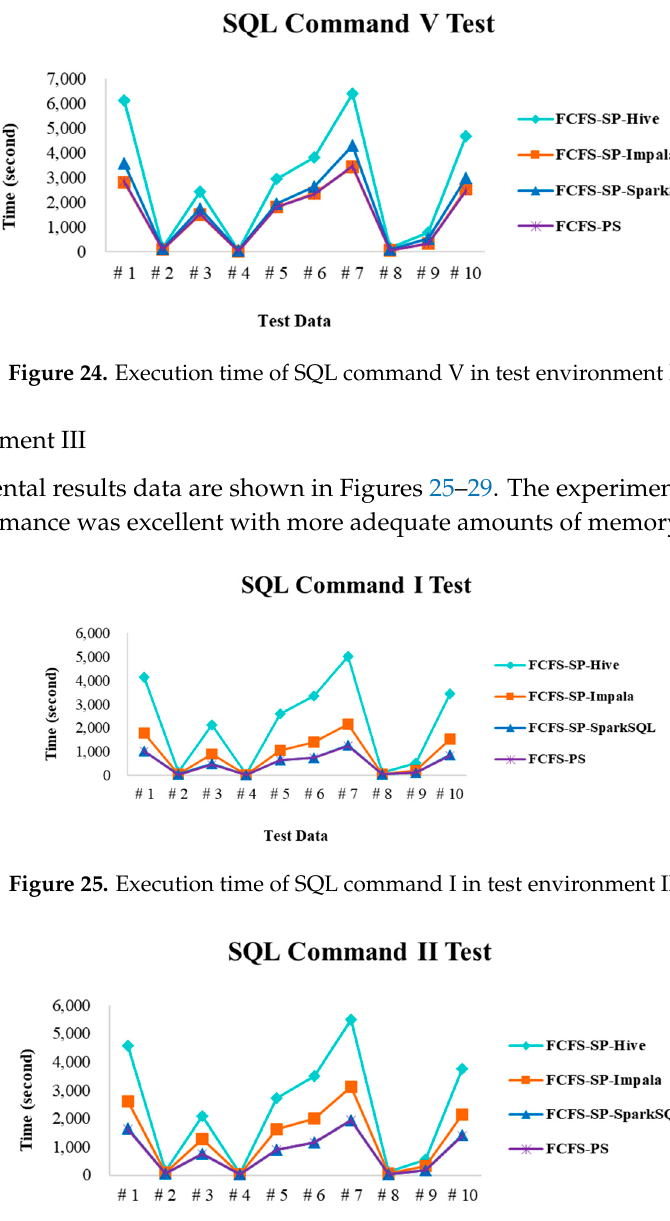
Figure 23. Execution time of SQL command IV in test environment II. Appl. Sci. 2018 , 8 , x FOR PEER REVIEW